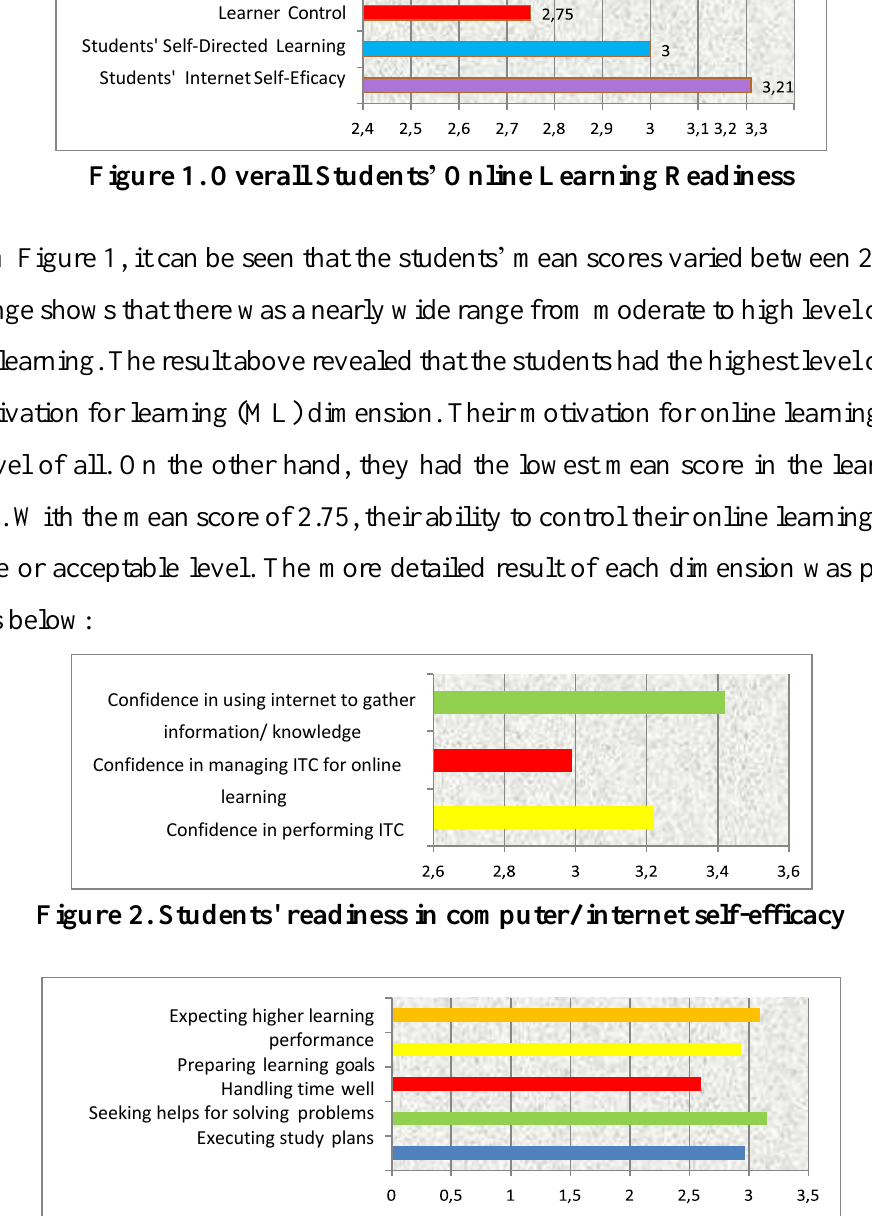
Figure 3. Students’ readiness in self-directed